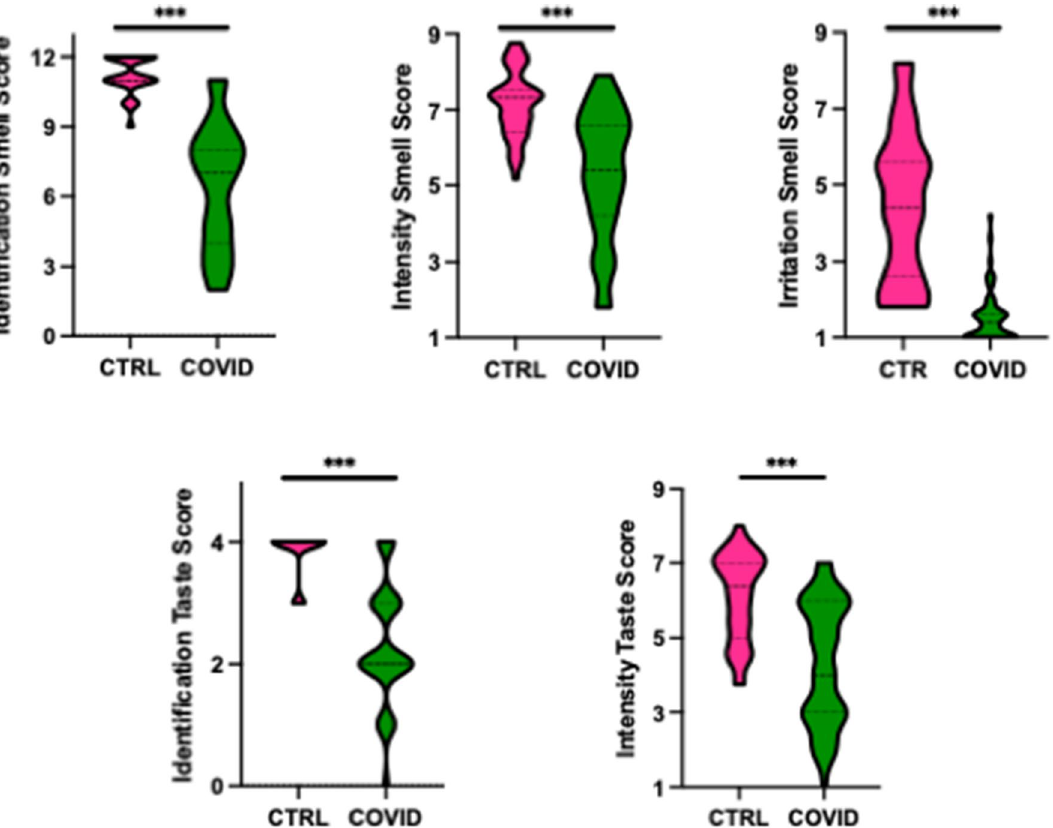
Figure 2. Violin plots showing the differences in olfactory and gustatory assessments in controls (CTRL) and cases (COVID). The plots provide a representation of data distribution and the median ± IQR within each group for each smell and taste assessments. Statistics according to Mann–Whitney U test; *** P < 0.001).